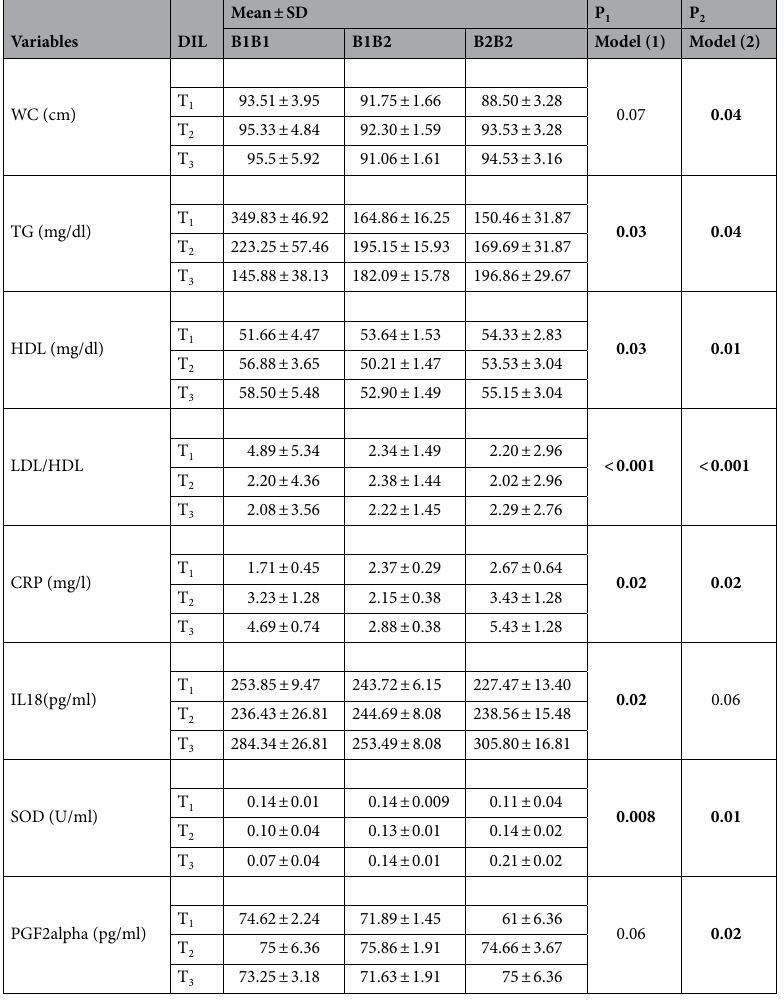
Table 4. Mean values of CVD risk factors across CETP genotypes (B1B, B1B2, B2B2) based on low and high DIL intake. Mean values of cardiovascular risk factors across CETP genotypes (B1B1, B1B2, B2B2) based on tertiles of DIL intake. P1: P-value for curd model; P2: P-value for the adjusted model by age, gender, physical activity, smoking, alcohol consumption, and familial history of diabetes. Bold values denote statistical significance at the p < 0.05